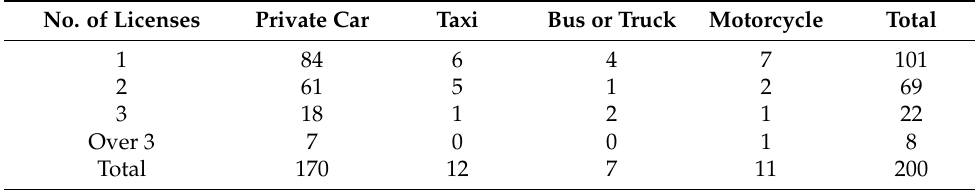
Table 2. Crosstab of vehicle type vs. number of drivers’ licenses.